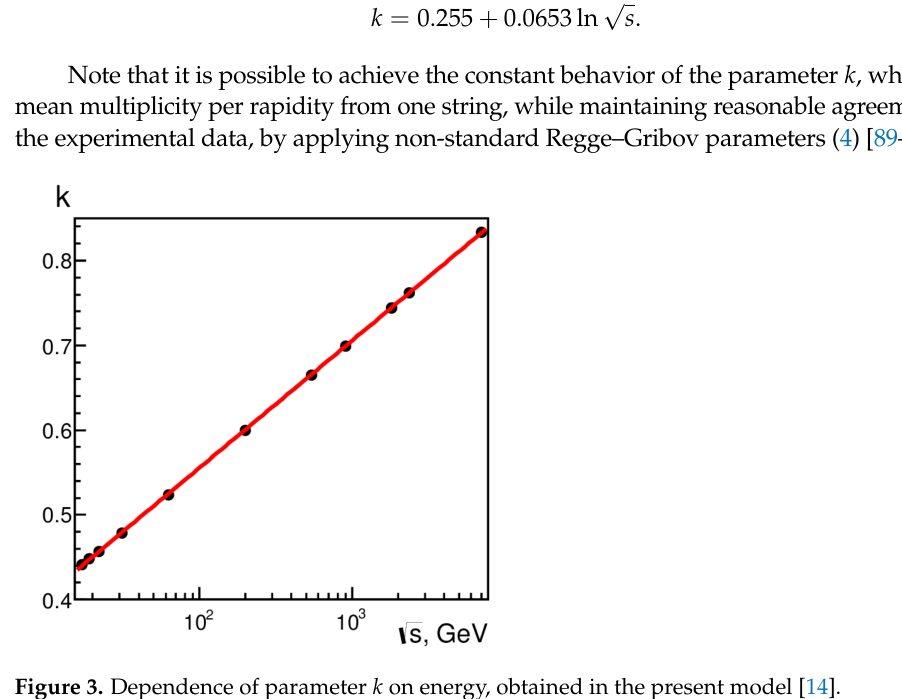
Figure 3. Dependence of parameter k on energy, obtained in the present model